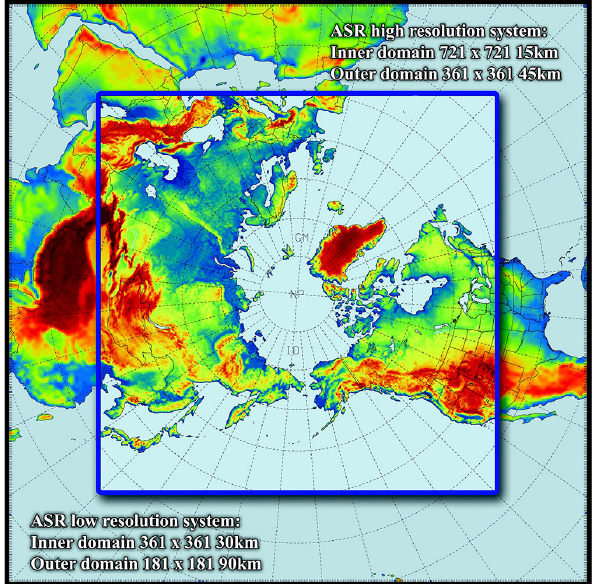
Fig. 1. The inner and outer domains of the Arctic System Reanalysis (ASR), at 30km and 90km resolution, respectively (http://polarmet.